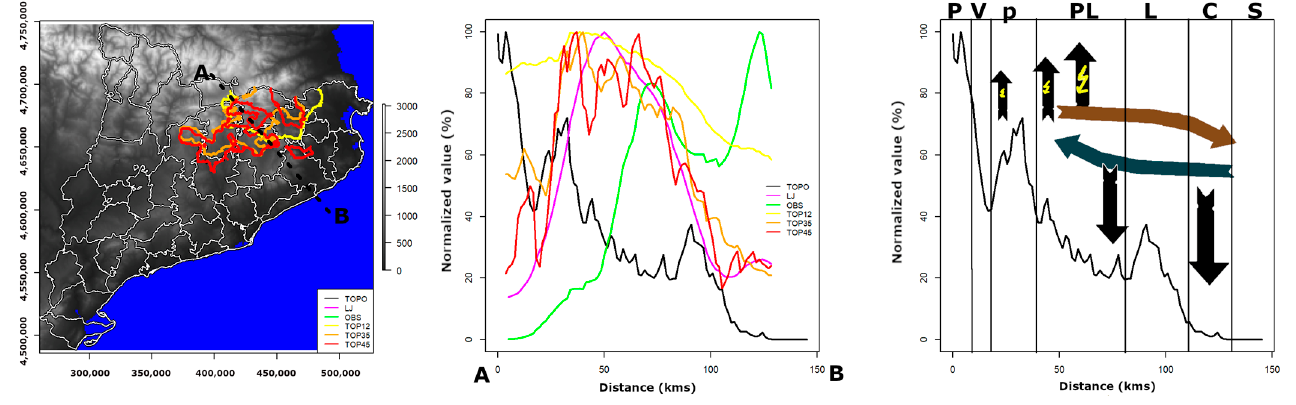
Figure 8. Left: map of the region of study (coordinates in the projection WGS 84/UTM zone 31N, EPSG:32631). The yellow, orange and red lines delimit the larger activity of TOP12, TOP35 and TOP45, respectively. The black dashed segment (with A and B in the extremes) indicates the profile shown in the other panels. Middle: normalized profiles of topography (black), LJ activity (purple), large hail observations (green), and TOP12, TOP35, and TOP45 (yellow, orange, and red) along the A–B transect. Right: the model of the thunderstorm’s behavior over the A–B transect. Black arrows indicate the vertical drafts (updrafts with lightning activity, and downdrafts associated with the hail precipitation), while blue and brown show the predominant warm and moist air mass, and the direction of the developed storms, respectively. The black thin vertical lines separate the different regions: P = Pyrenees, V = Valley, p = Pre-Pyrenees, PL = Plain, L = Littoral Range, C = Coast, and S = Sea.